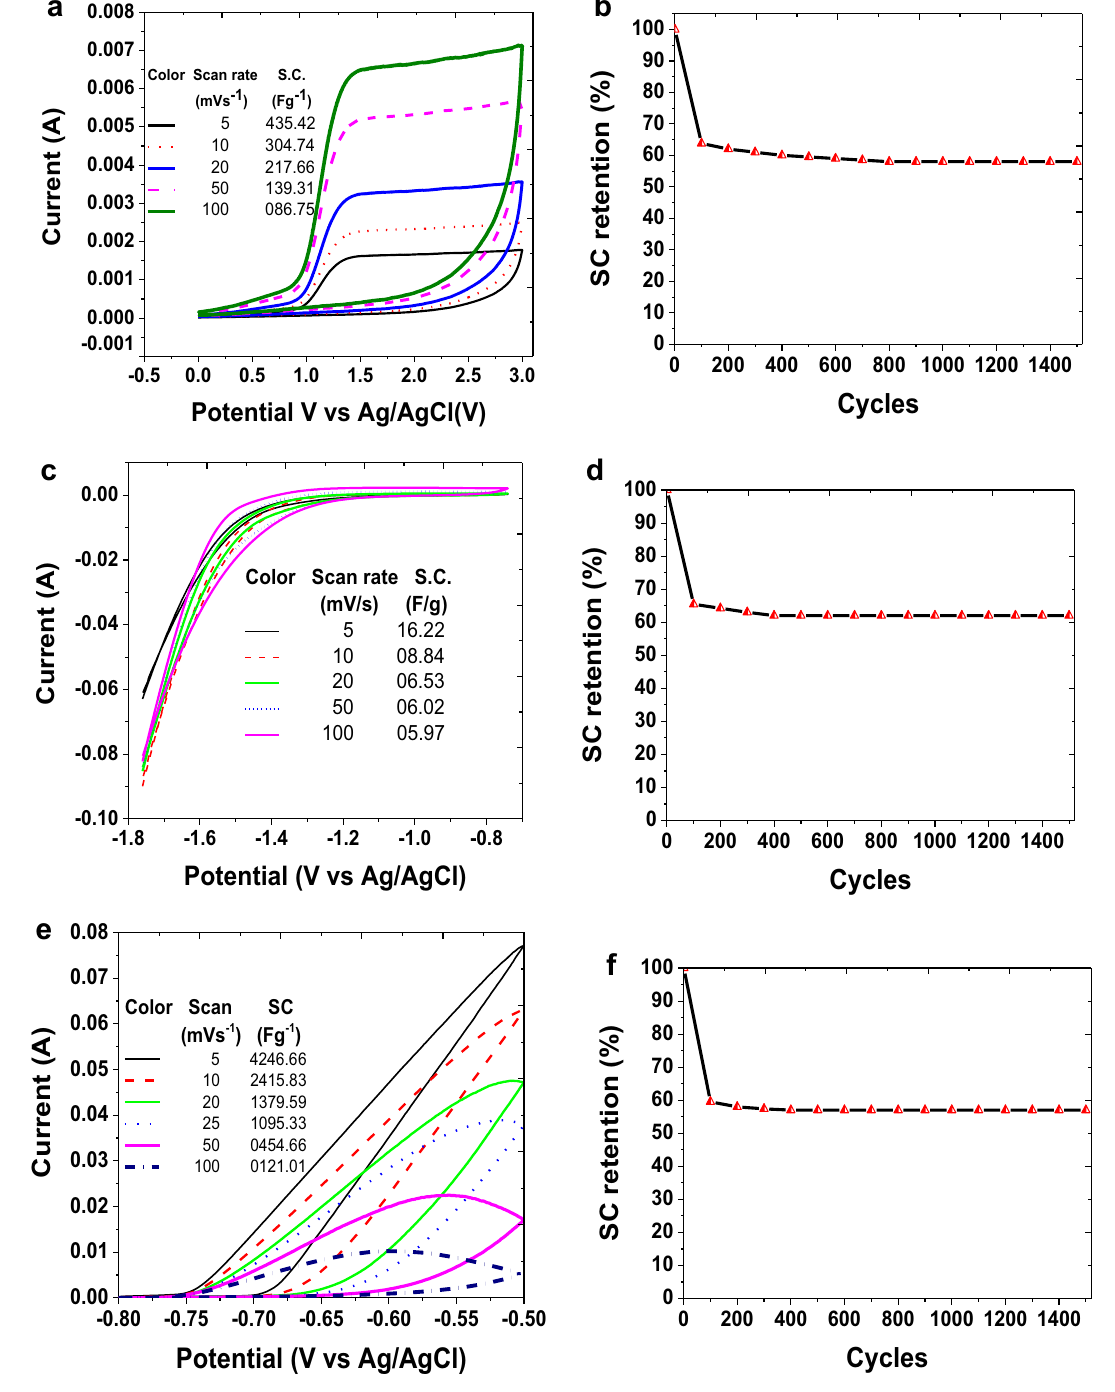
Fig. 3 a Cyclic voltammograms of HFE at different scan rates and b cyclability study of HFE in H ferent scan rates and d cyclability of HFE in Na 2 SO 4 . e Cyclic voltammograms of HFE at different scan rates and f cyclability study in K 2 SO